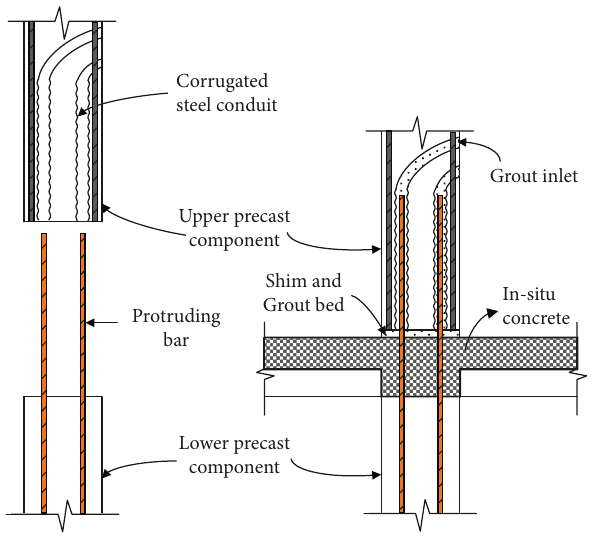
Figure 1: Rebar lapping by corrugated steel